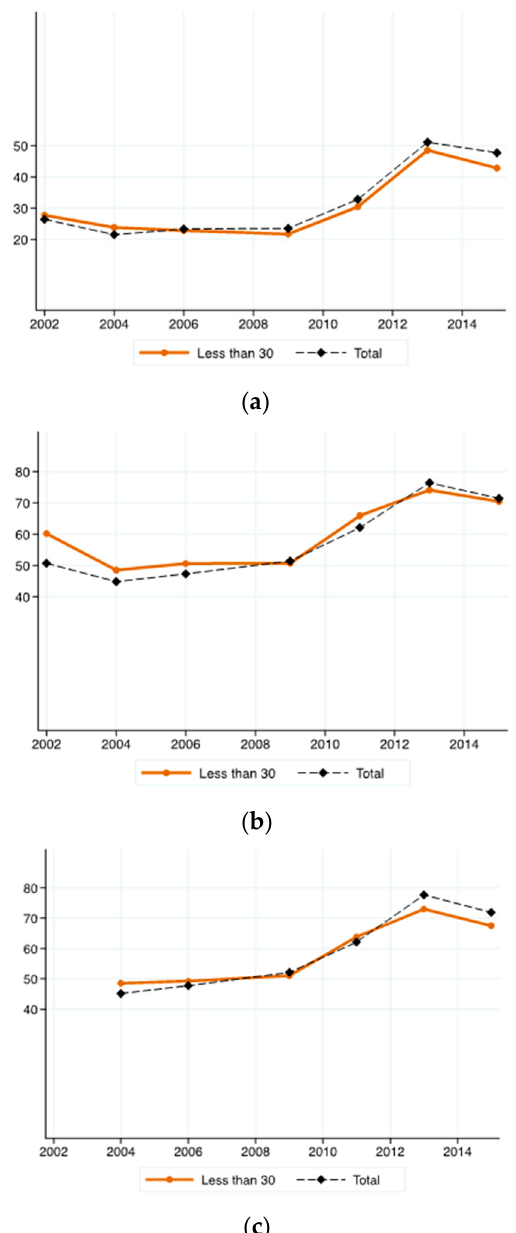
Figure 5. Young people’s mistrust in political institutions. ( a ) Mistrust in Parliament, measured as the percentage of individuals with low trust in Parliament (0–3 in a 0–10 scale); ( b ) mistrust in politicians, measured as the percentage of individuals with low trust in politicians (0–3 in a 0–10 scale); ( c ) mistrust in political parties, measured as the percentage of individuals with low trust in political parties (0–3 in a 0–10 scale). Source: European Social Survey, rounds 1–7 (Spain).